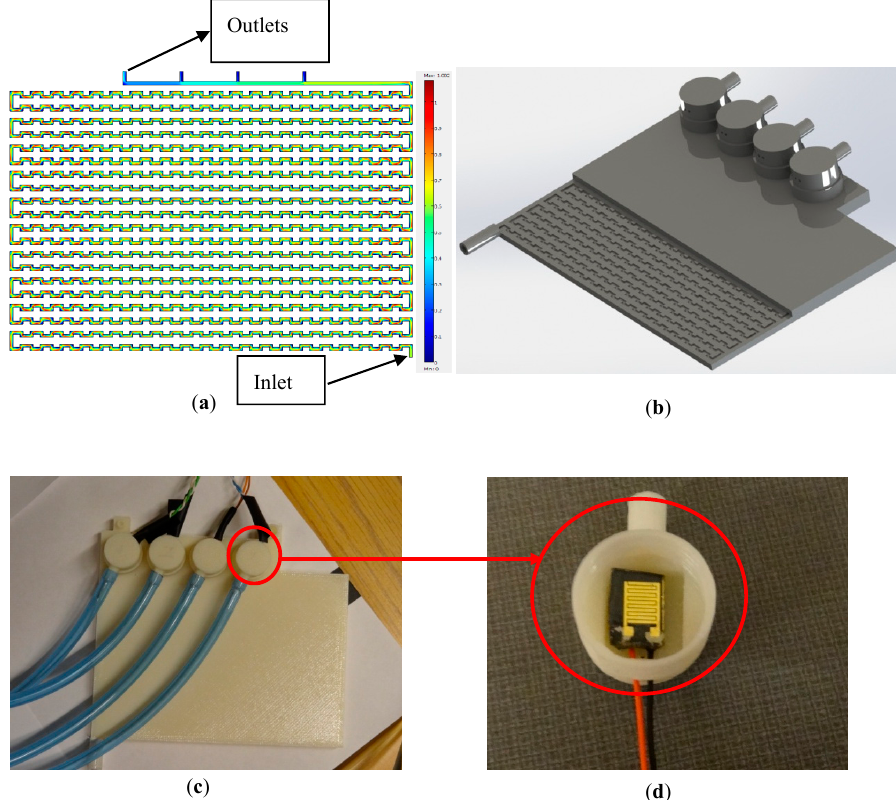
Figure 1. Fabrication of the interface using 3D. ( a ) Comsol simulation of the interface; ( b ) CAD model of the interface; ( c ) fabricated interface; and ( d ) pH sensor fitted into the interface.